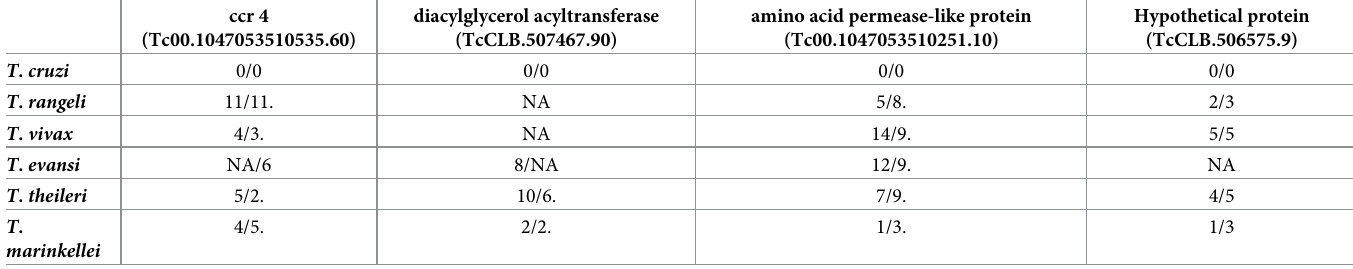
Table 3. Species specificity of primers within Trypanosoma